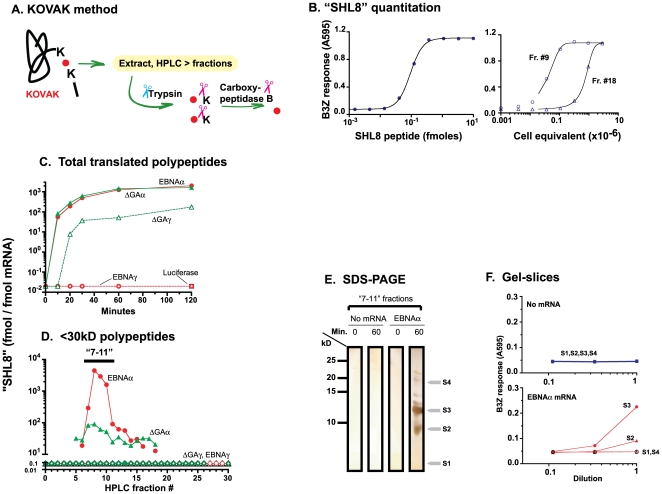
Truncated translation products are antigenic precursors.(A) Schematic illustration of the KOVAK method for detection and quantitation of proteolytic intermediates. The SHL8 (SIINFEHL) codons (red circle) are flanked at the N- and C-termini by lysine (K) residues. The putative products of translation are collected in 10% acetic acid before HPLC fractionation. Each fraction is treated with trypsin and carboxypeptidase B (CPB) to release the optimally active SHL8 peptide. (B) The amount of embedded SHL8 in the proteolytic intermediates (“SHL8” activity) is shown in two representative HPLC fractions (#9 and #18). The B3Z stimulating activity in dilutions of fraction #9 and #18 was compared with a standard curve generated with synthetic SHL8 peptide. (C) The indicated mRNA coding for EBNAα, EBNAγ, ΔGAα, ΔGAγ and luciferase as a negative control, were translated in vitro for varying time periods. Polypeptides in aliquots of the translation reactions were extracted assayed without HPLC fractionation as in (A). (D) Products translated in 60 min. in vitro from the indicated mRNAs were passed through a 30kD molecular weight filter. The filtrate (<30kD) was fractionated by HPLC and the amount of “SHL8” activity in each fraction was determined. Data shown represent 3 different experiments. (E) Polypeptides translated from EBNAα mRNA and eluting in “7–11” HPLC fractions in (C) were fractionated on high resolution tricine 16.5% SDS-PAGE gels. “No mRNA” samples were analyzed in parallel as negative controls. The silver-stained gel shown is representative of 3 different experiments. (F) Indicated slices (S1–S4) were excised from the gel, treated with trypsin and CPB and dilutions were tested for “SHL8” activity with SHL8/Kb-specific B3Z lacZ inducible T cell hybridoma and Kb-L cells as APC. The conversion of the lacZ substrate chlorophenol β-D-pyrannoside was measured as absorbance at 595 nm with 655 nm as reference wave length. Data are representative of 3 different experiments.